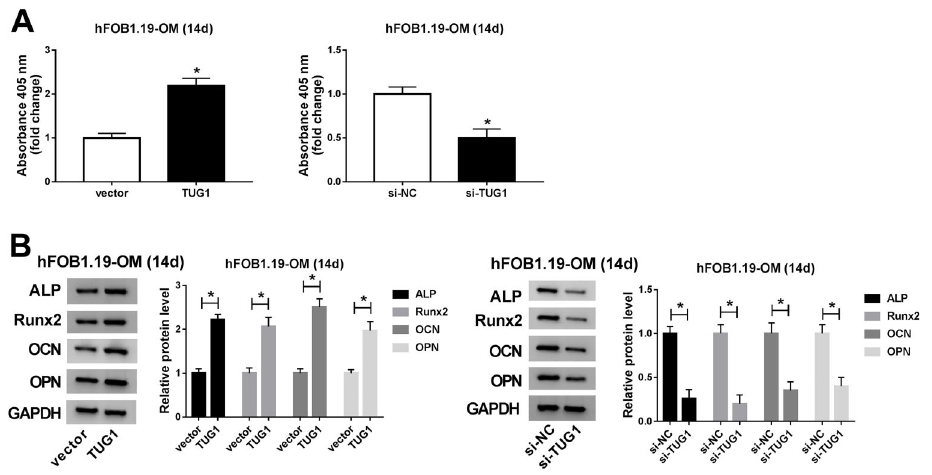
Figure 4. TUG1 facilitated hFOB1.19 cell differentiation. A , The activity of ALP in osteogenic differentiated hFOB1.19 cells was detected after TUG1 was upregulated or down-regulated. B , The protein levels of ALP, Runx2, osteocalcin (OCN), and osteopontin (OPN) in osteogenic differentiated hFOB1.19 cells were measured after transfection with TUG1 or si-TUG1. Data are reported as means ± SD of three independent experiments. *P o 0.05 ( t